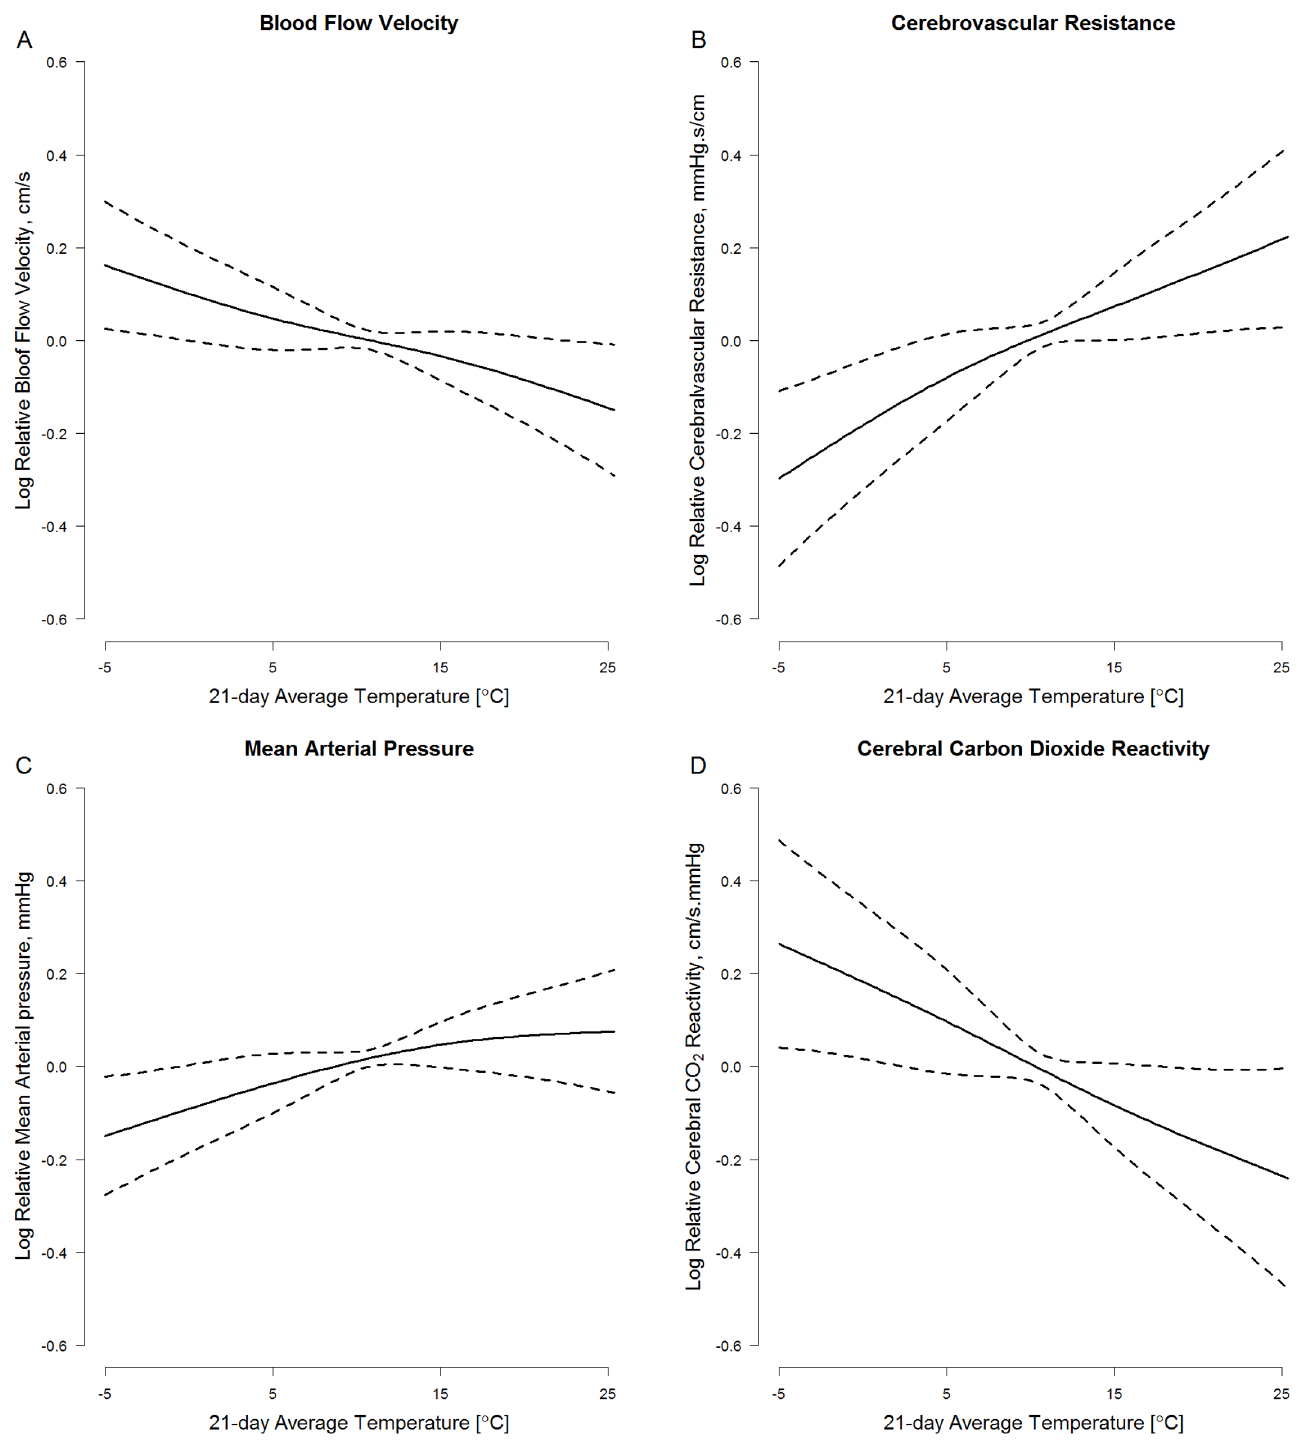
Fig 2. Exposure-response functions between 21-day average ambient temperature and (A.) resting blood flow velocity, (B.) resting cerebrovascular resistance, (C.) resting mean arterial pressure, and (D.) cerebral varoreactivity modeled using natural cubic splines with 3 degrees of freedom. Dashed lines represent 95% confidence intervals.